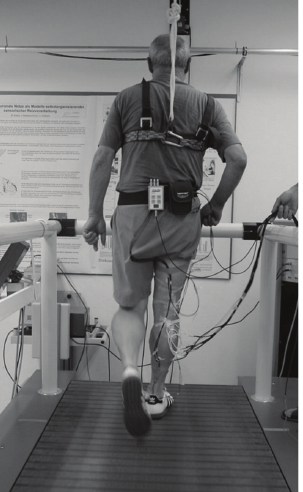
Figure 6: Assessment of reactive balance performance using a motorized treadmill (i.e., unexpected decelerating gait perturba- tions during walking will be